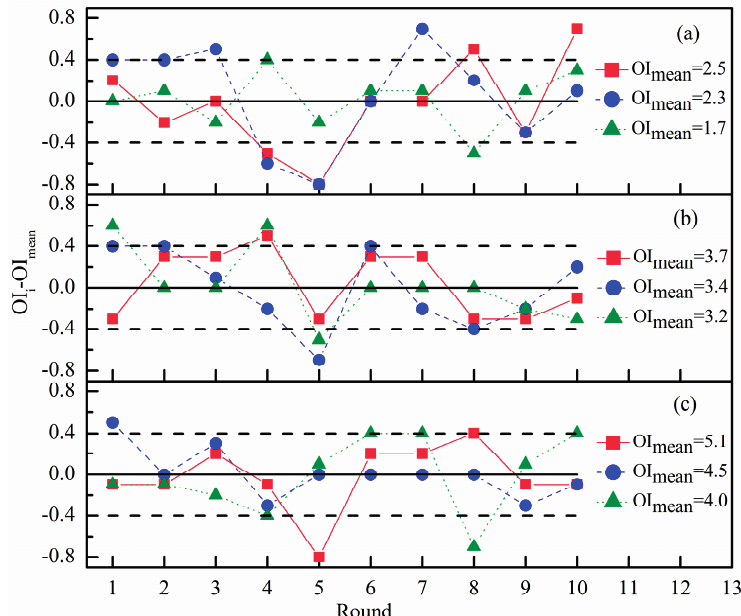
Figure 5. The precision of odor intensity evaluation in repeated tests for nine different odor samples of propionaldehyde (PA) and n -valeraldehyde (VA) mixture at ( a ) low odor intensity level; ( b ) middle odor intensity level and ( c ) high odor intensity